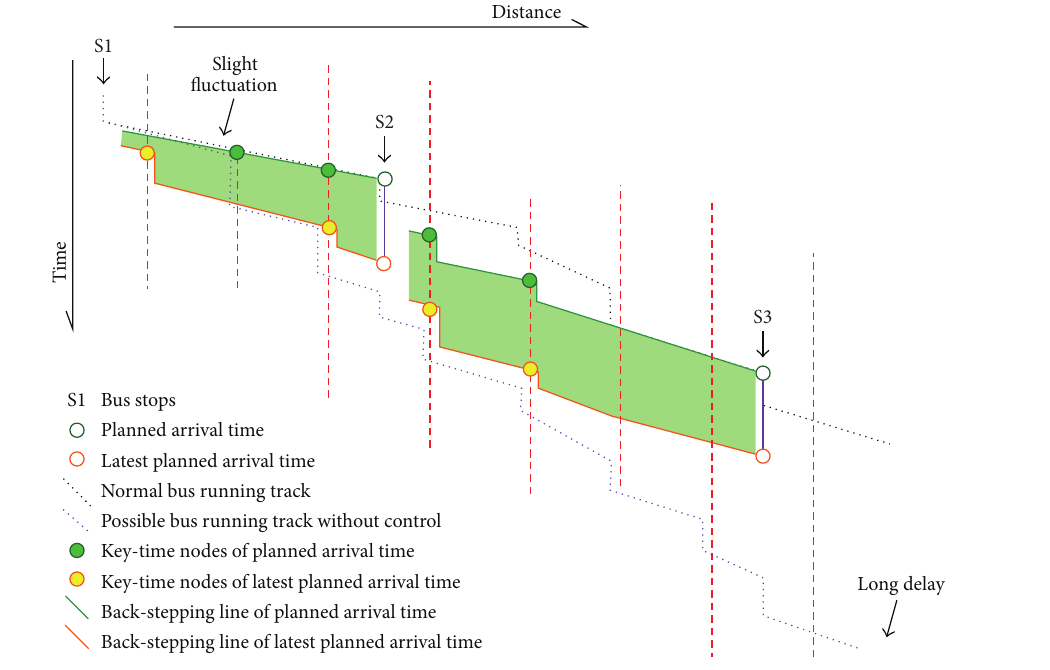
Figure 2: The basic concept of the proposed control. Table 1: